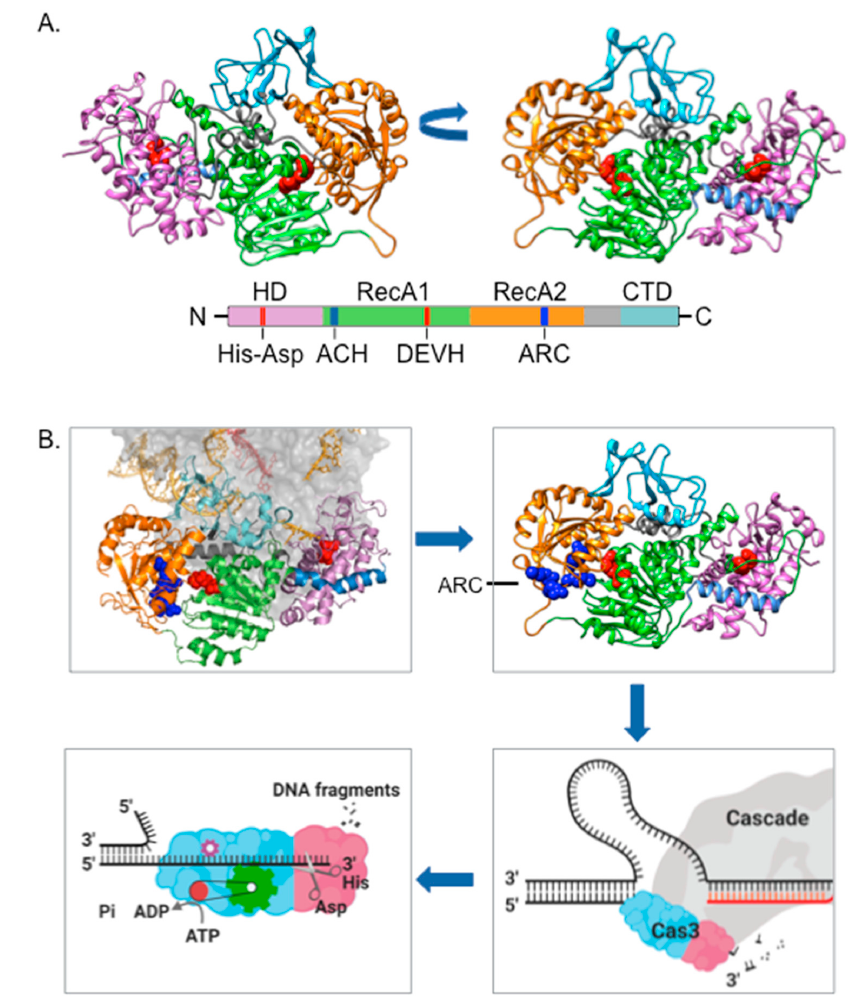
Figure 2. Cas3 structure-function. A. PHYRE2-predicted Escherichia coli Cas3 structure, modeled from Cas3 structures solved from Thermobaculum terrenum (PDB 4Q2C) and Thermobifida fusca (PDB 4QQW, 4QQX and 4QQY), represented in two orientations and with a corresponding cartoon of primary sequence presented below. We highlight the HD domain (purple), two RecA-like domains (green and orange) and the accessory C-terminal domain (CTD, pale blue). Active sites comprising the Asp-His HD domain and the amino acid DEVH motif of one RecA-like domain for ATP-hydrolysis are highlighted in red spheres within the structures, and marked on the cartoon primary structure. Also marked are the prominent solvent-exposed alpha helix (ACH) and an arginine rich channel (ARC) described in the main text. B. Panels should be followed from top left, clockwise. The location of Cas3 (using same domain colors as used in part A) bound to Cascade subunit protein Cse1 (grey), presented from the T. fusca Cascade-Cas3 structure (PDB: 6C66). DNA parts of the R-loop are colored orange—in CRISPR interference this DNA is nicked by the Cas3 HD domain, and then assimilated into the translocase/helicase active sites, possibly via interaction between DNA and the arginine residues of the ‘ARC’, highlighted as blue spheres . Captured single-strand DNA (ssDNA) is then translocated through the Cas3 protein by a reeling mechanism, which is associated with nuclease activity that generates DNA fragments.